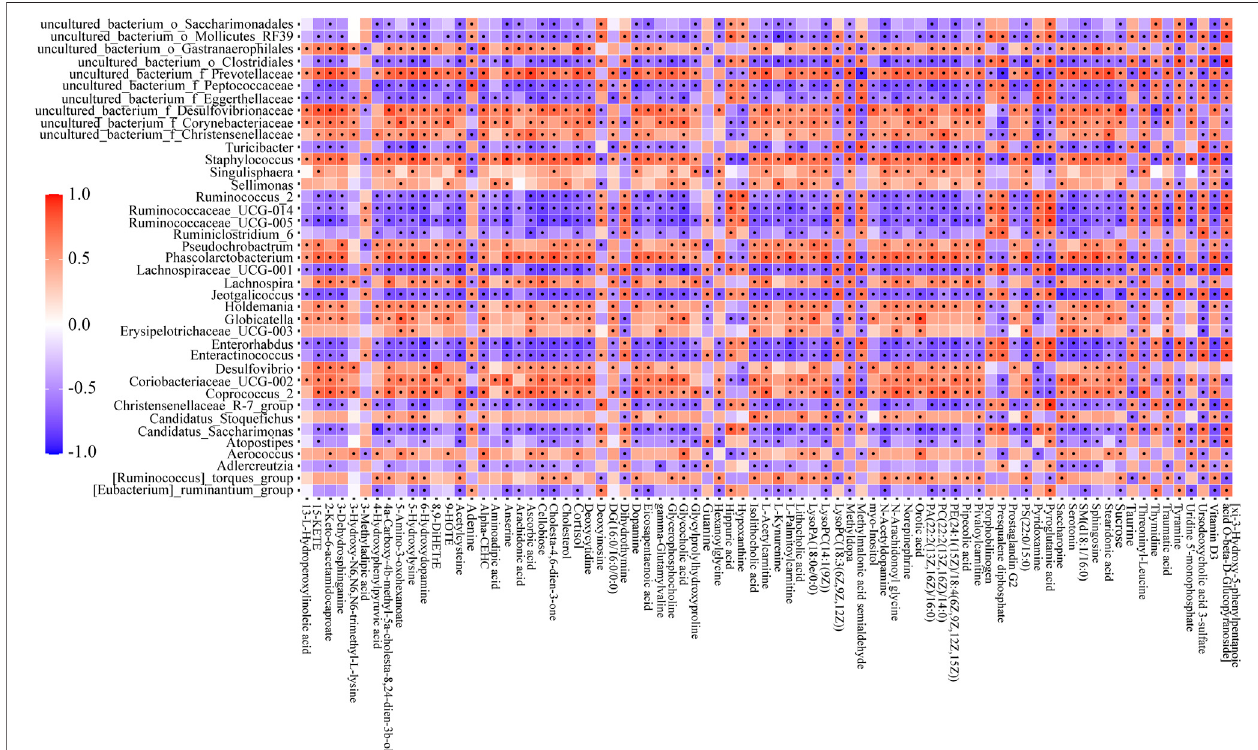
FIGURE 6 | Correlation heatmap between perturbed gut microbiota genera and altered biomarkers in NG and MG. Signi fi cant correlations (r > 0.5 or r < − 0.5, p < 0.05) were marked with dots.